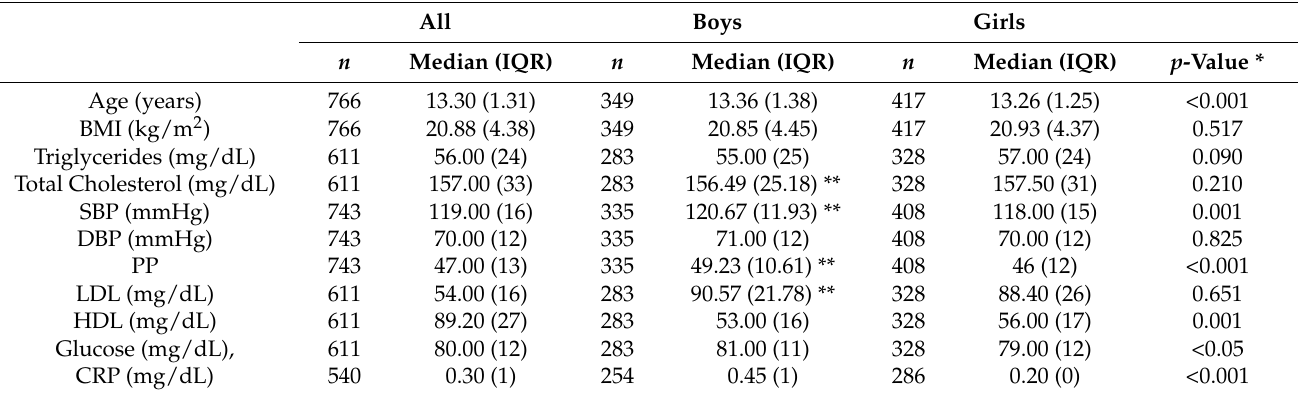
Table 2. Descriptive characteristics of the TEENAGE